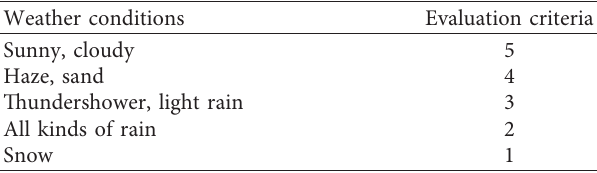
Table 2: Numerical table of weather factors.